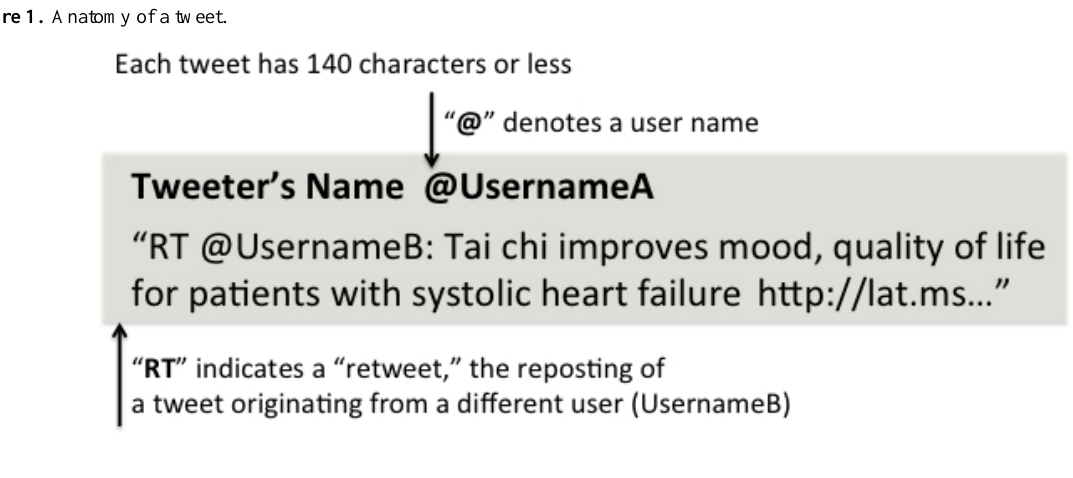
Figure 1. Anatomy of a